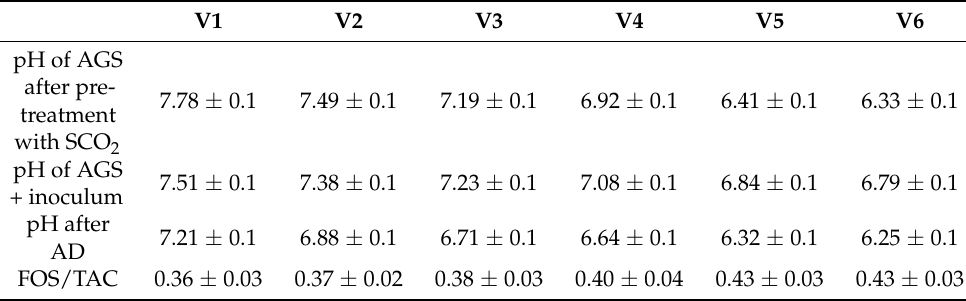
Table 3. Changes in pH values upon pretreatment and AD, and FOS/TAC after AD.